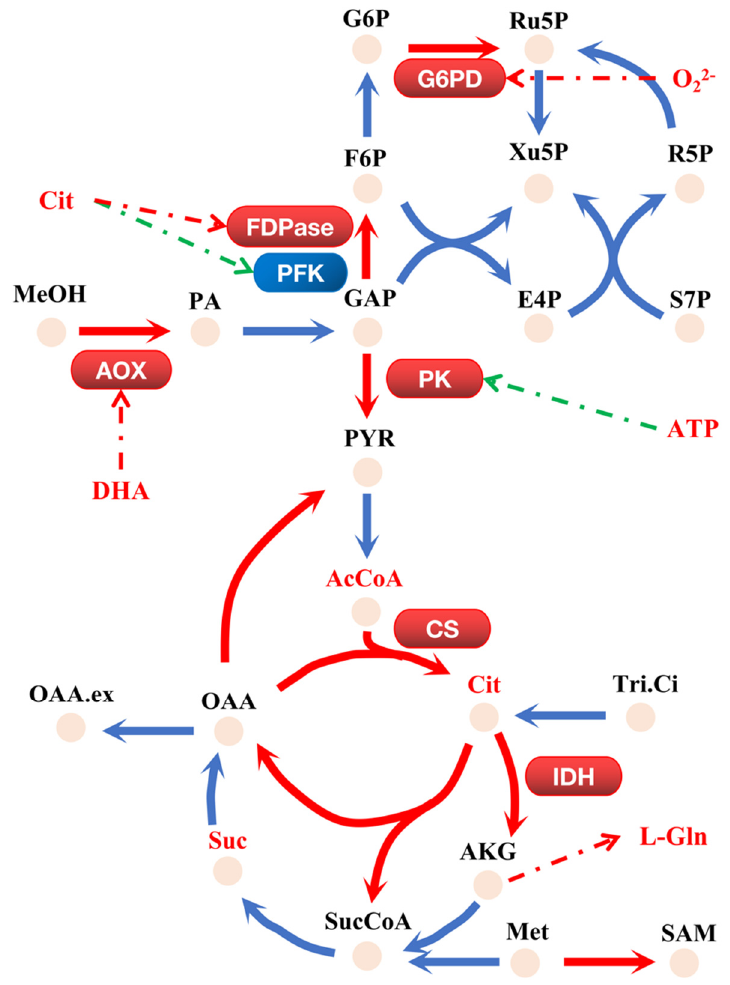
Figure 5. Putative regulatory mechanisms revealed by integrated untargeted metabolomics and metabolic flux analysis regarding the effect of sodium citrate on the fermentation of P. pastoris (The red capsules and red arrows indicate the enzymes whose activity appears to be increased and the corresponding reactions; the red font indicates the metabolites whose intracellular content appears to be up-regulated; the red and green dashed lines indicate the activating and inhibiting effects, respectively; and the blue capsules indicate the enzymes whose activity is inhibited. AOX is alcohol oxidase, G6PD is glucose-6-phosphate dehydrogenase, PFK is phosphofructokinase, FDPase is fructose 1,6-diphosphate phosphatase, PK is pyruvate kinase, CS is citrate synthase, IDH is isocitrate dehydrogenase).